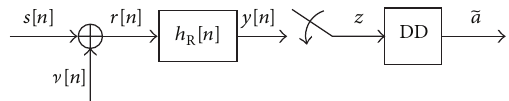
Figure 1: Discrete-time domain communication system